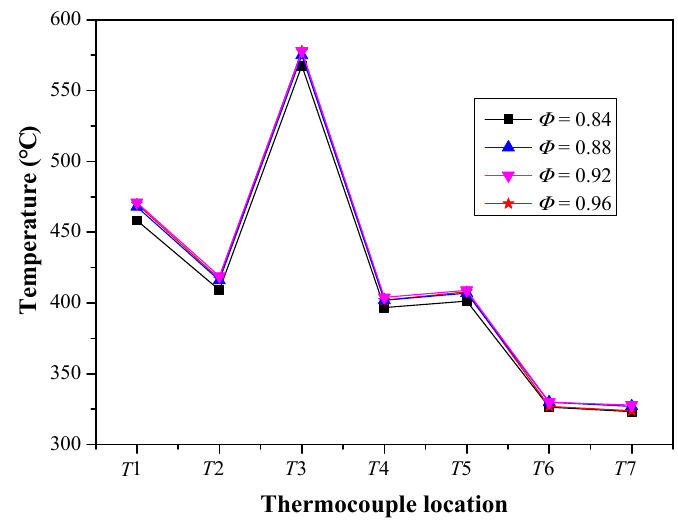
Figure 8. The temperature distribution of the combustor with different equivalence ratios, v = 0.4 m/s.